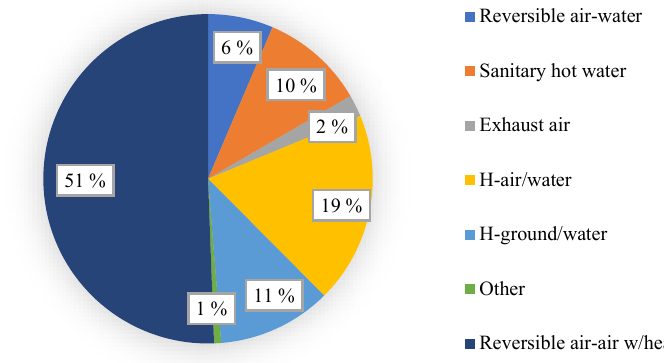
Fig. 3. The total number of heat pumps sold in 2009–2018 by